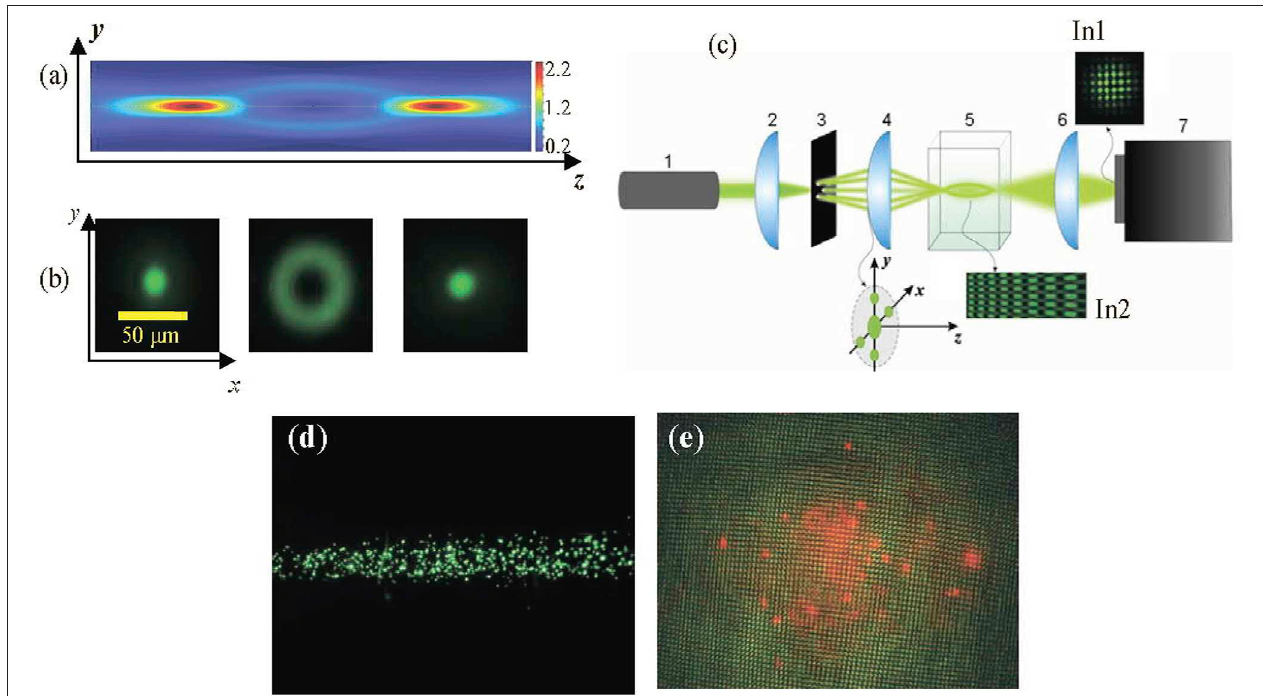
FIGURE 10 | (a) Longitudinal and (b) transverse cross sections of a bottle beam. (c) Experimental setup for generation of the regular set of 3D optical traps [118]: laser 1 emits radiation with λ 532nm, which through the collimating lens 2, the amplitude transparency (2D diffraction grating) 3 and microscopic objective 4 enters = cuvette 5 with carbon particles. The lens 6 projects the cuvette interior into the CCD camera 7. Insets In1 and In2 show the longitudinal and transverse intensity distribution in the multiple-trap beam. (d,e) Longitudinal and transverse views of the beam in the cuvette with trapped particles [in (e) , the particles are additionally illuminated by the red